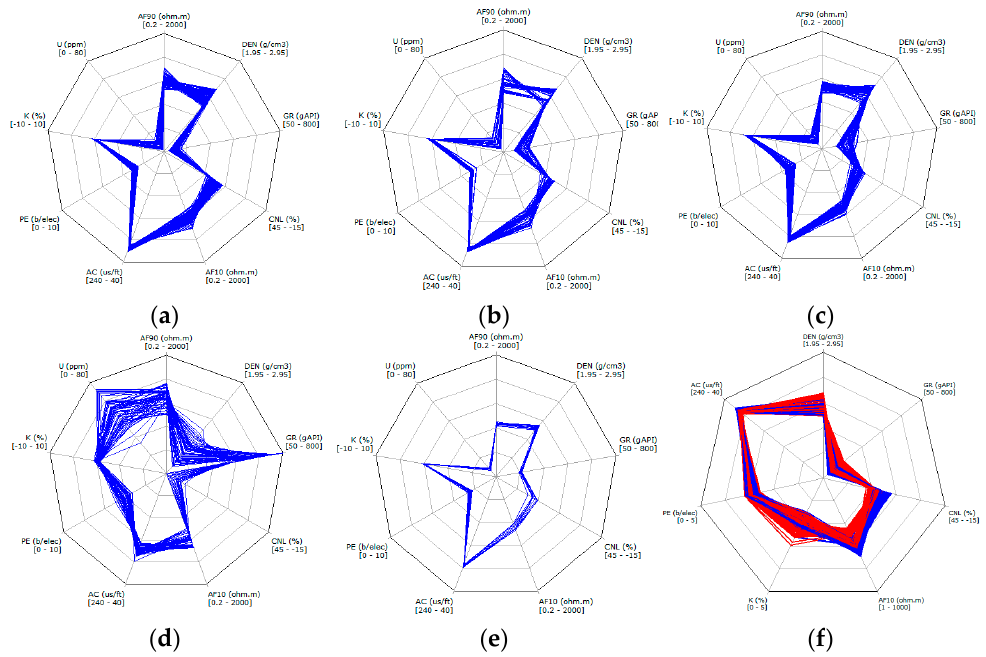
Figure 7. Radar chart of five kinds of lithology logging curve characteristic analysis. ( a ) Medium natural gamma siliceous shale; ( b ) High natural gamma siliceous shale; ( c ) High natural gamma clayey shale; ( d ) Very high natural gamma siliceous shale; ( e ) High natural gamma tuff shale; ( f ) Separate analysis of shale layers.